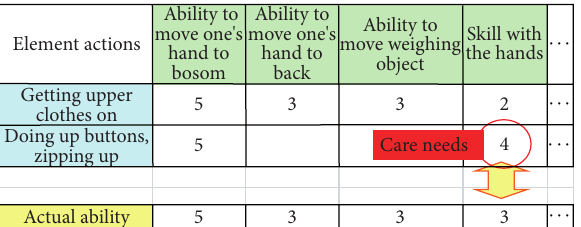
Figure 5: Action Flow.